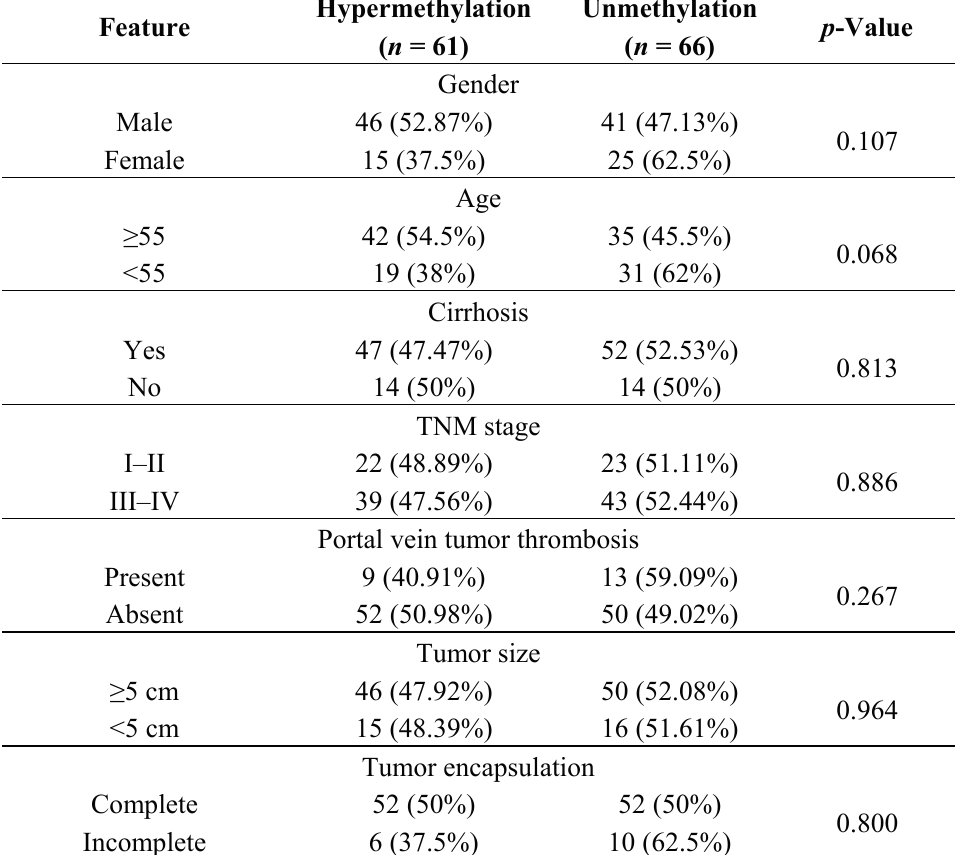
Table 1. SOCS3 CGI hypermethylation and clinicopathological correlations in